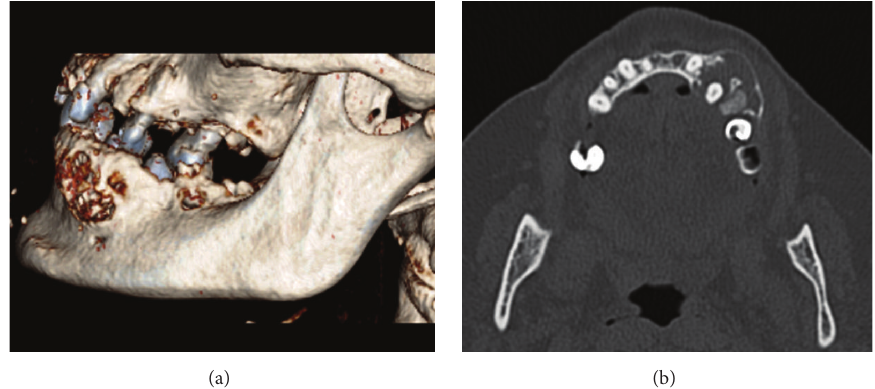
Figure 2: (a) Three-dimensional computed tomography (CT) reconstruction showing an expansion of the left-side of the mandible with some erosion areas on buccal cortical surface. (b) Axial CT image showing a low-density multilocular